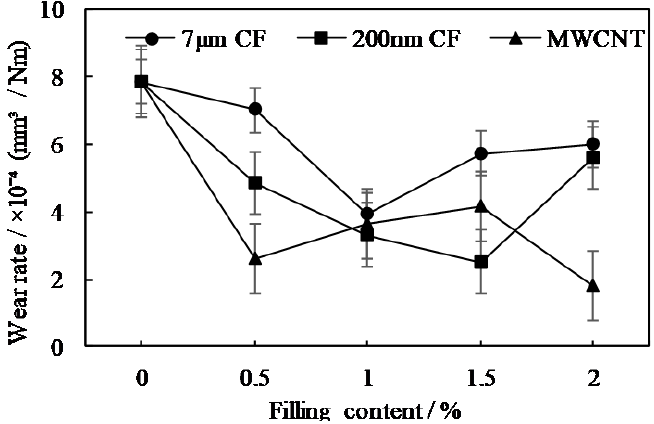
Figure 13. Wear rate of micro/nano CF and MWCNT filled modified PTFE composites.